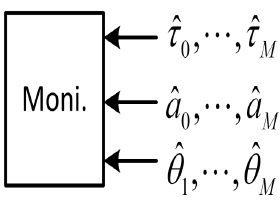
Figure 2. CADLL monitoring